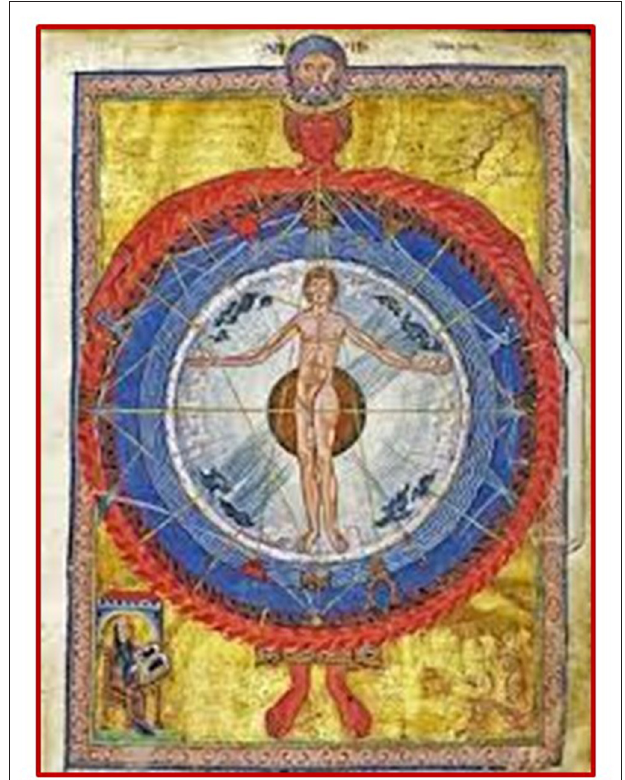
FIGURE 1 | Liber divinorum operum, f 9r., sec. XIII, Biblioteca Statale di Lucca, ms. 1942: it represents the close relationship between human beings and the universe, between macrocosm and microcosm. The wheel delimited by the embrace of the Spirit fire represents all of the creation made up of the four elements: air, water, earth, and fire. The four elements are closely integrated and interpenetrated with one another. At the center of the wheel appears the human being: the winds’ blows and the cosmic rays converge on it to demonstrate the close relationship of interdependence between visible and invisible and between macrocosm and microcosm. The bottom left is Hildegard von Bingen.